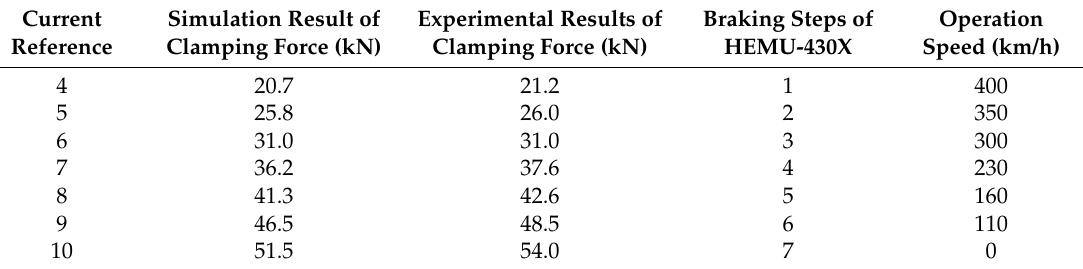
Table 3. Clamping force for current